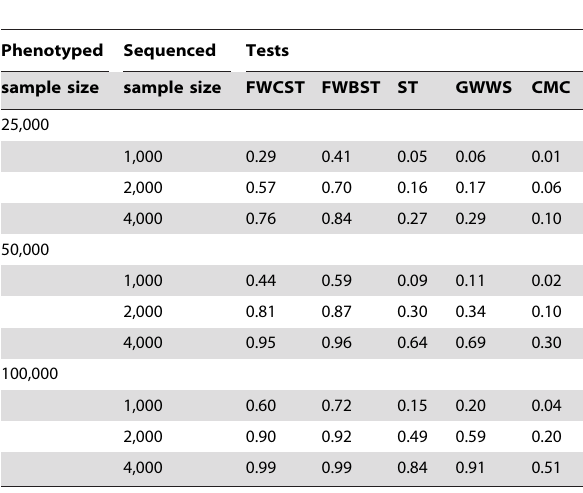
Table 2. Power with phenotyped and sequenced sample sizes.